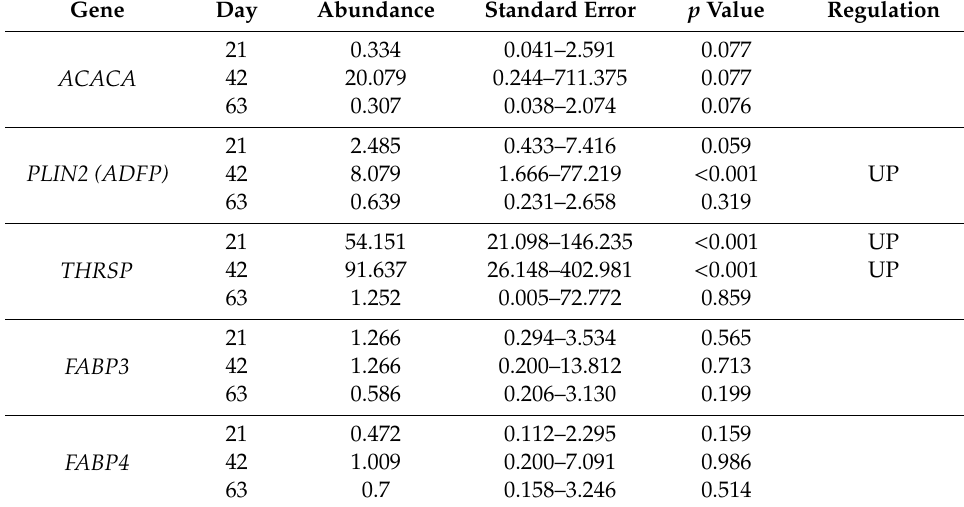
Table 4. Relative abundance of genes involved in lipid metabolism in milk somatic cells from cows fed olive oil (OO) using the control (no fat supplementation) as the reference condition (control vs. OO, in each sampling